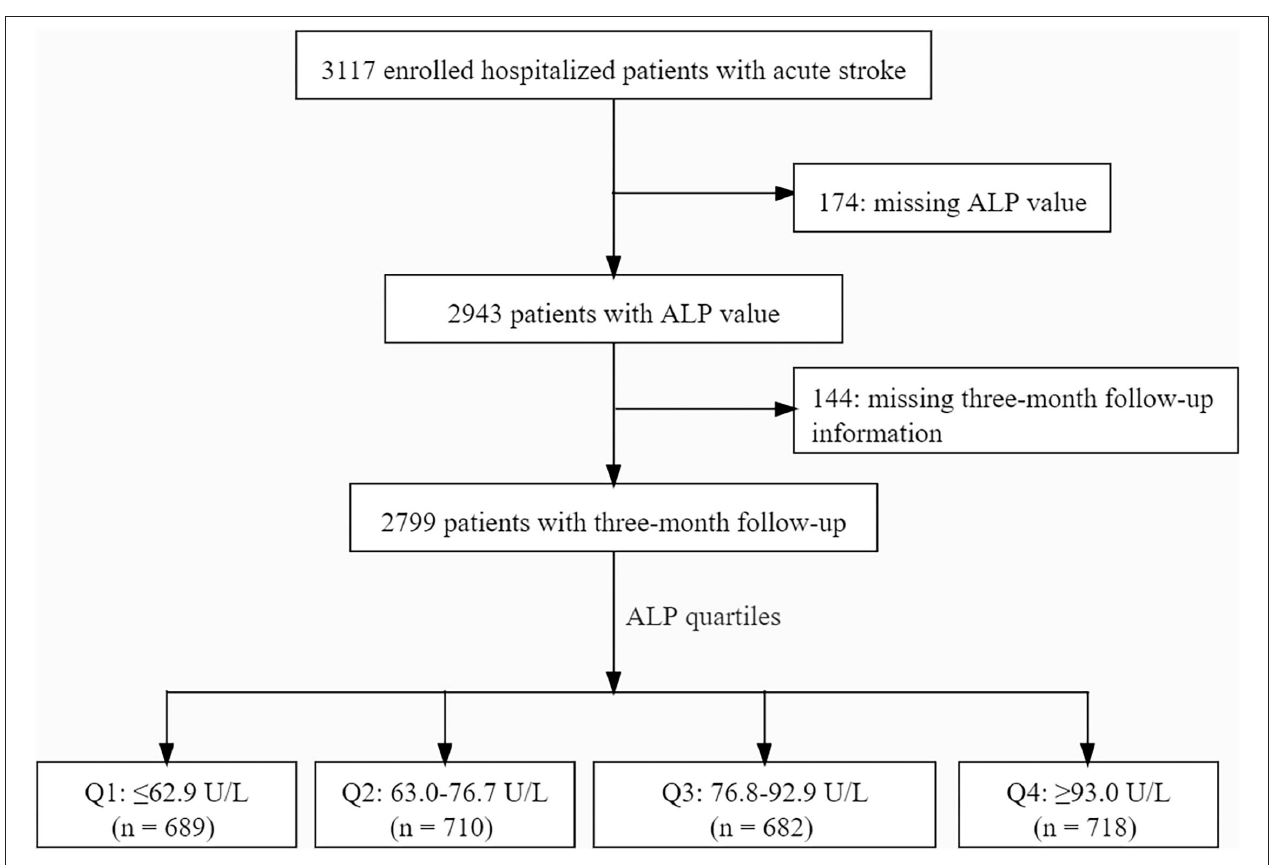
FIGURE 1 | Flowchart of patient enrollment. ALP, alkaline